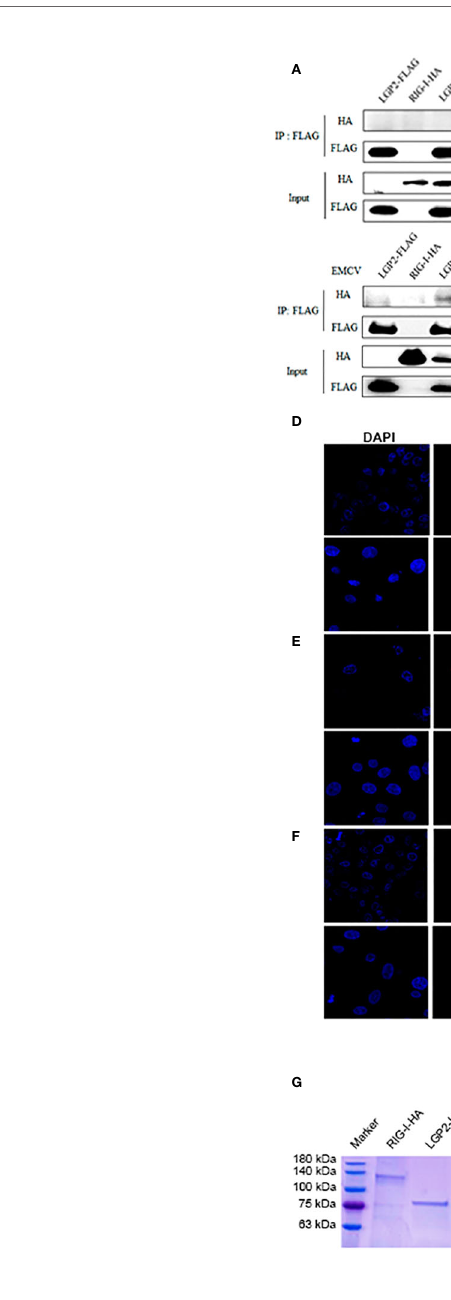
FIGURE 7 | Porcine LGP2 interacts RIG-I and MDA5 upon activation and promotes their RNA binding. (A) pLGP2-FLAG (1 m g) and pRIG-I-HA (1.5 m g) were co- transfected into 293T cells in 6-well plate (8×10 5 cells/well) for 24 h, then infected with or without 0.01 MOI EMCV for 8 h. The cells lysates were immunoprecipitated with anti-FLAG mAb and subjected to Western-blotting using the indicated antibodies. (B) pLGP2-FLAG and pMDA5-HA were co-transfected into 293T, and the transfected cells were treated and processed as in (A) . (C) pMDA5-FLAG and pRIG-I-HA were co-transfected into 293T cells, and the transfected cells were treated and processed as in (A) . (D) PAMs grown on 15-mm glass bottom cell culture dish (5×10 5 cells) were co-transfected with pLGP2-HA (0.75 m g) and pRIG-I-FLAG (0.75 m g) for 24 h, then infected with or without EMCV for 8 h. The cells were examined for co-localization by con-focal fl uorescence microscopy. (E) pLGP2-HA and pMDA5-FLAG were co-transfected and the transfected PAMs were treated and examined for co-localization as in (D) . (F) pRIG-HA and pMDA5-FLAG were co- transfected, and transfected PAMs were treated and examined for co-localization as in (D) . (G) The puri fi ed pLGP2-HA, pLGP2-FLAG, pRIG-HA and pMDA5-FLAG were analyzed by SDS-PAGE. (H) pLGP2-HA, pRIG-I-HA and pMDA5-FLAG were incubated in tubes alone or together as indicated, then 1 m g dsRNA poly (I:C) HMW Biotin and 30 m L streptavidin agarose were added for binding. The dsRNA bound proteins were analyzed by